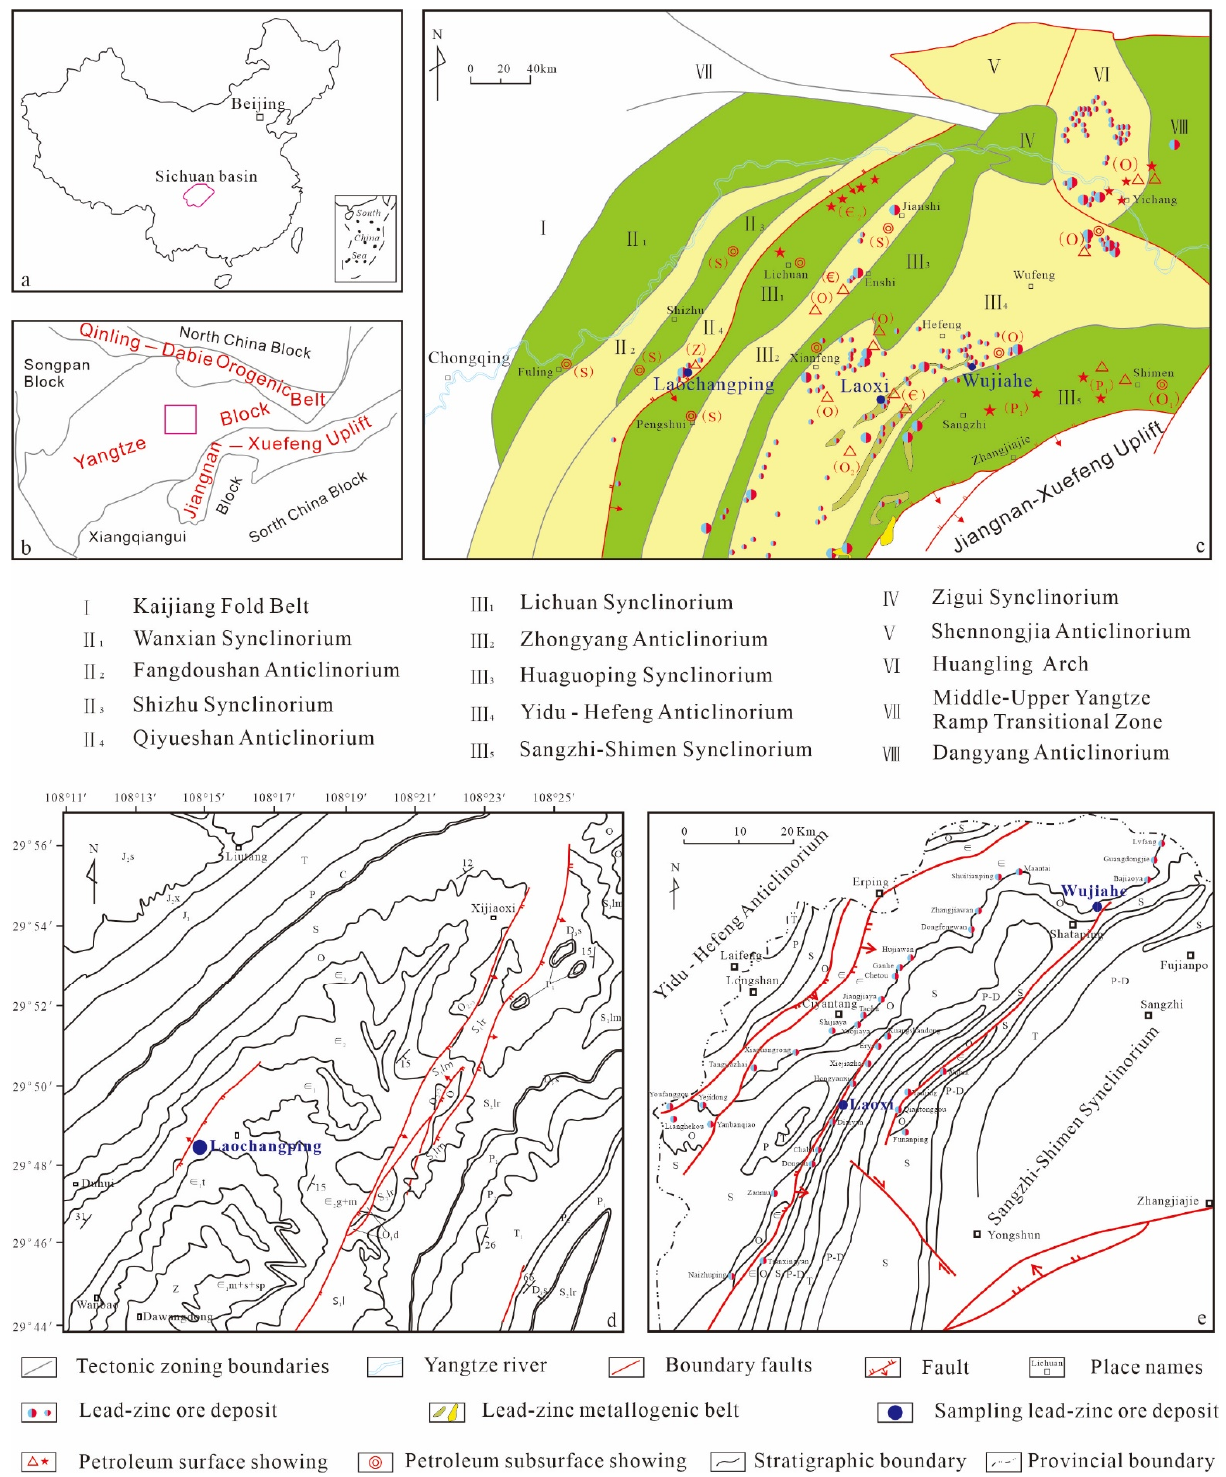
Figure 1. ( a ) Location of the Sichuan Basin in China; ( b , c ) simplified geological map of the margin of the eastern Sichuan, south China; ( d ) geologic map of the Laochangping Pb-Zn deposit; ( e ) geologic map of the Luota Pb-Zn deposit. Since the development of the basement (Yangtze craton), this study area has been affected by the Paleozoic Caledonian-Hercynian (541–251 Ma), Triassic Indosinian (251–